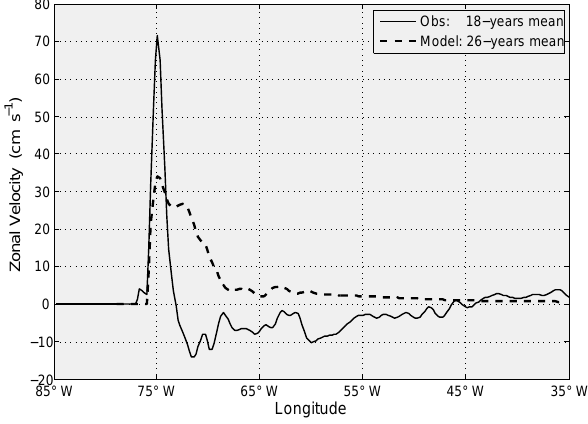
Fig. 3. Zonal geostrophic velocity sections at 35 ◦ N: 18-yr (1993– 2010) climatology computed from altimeter data distributed by AVISO/Cnes (solid line); 26-yr mean of model response (dashed